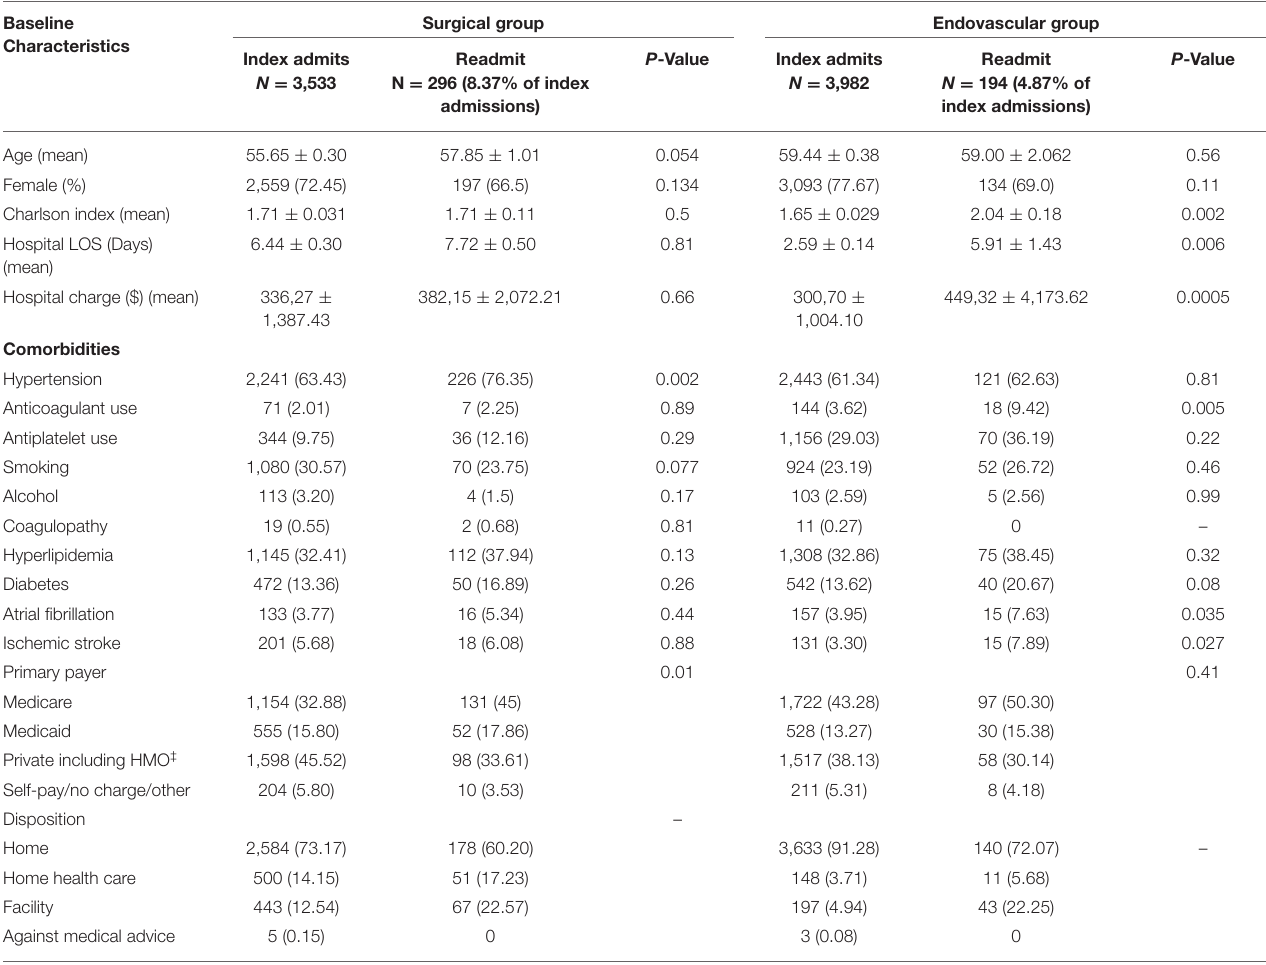
TABLE 1 | Baseline characteristics of study patients with UIAs who underwent surgical or endovascular